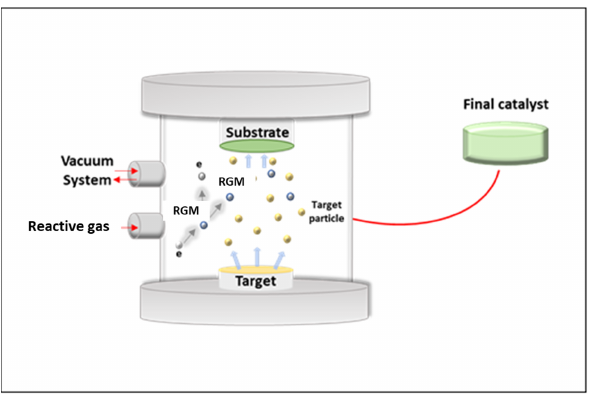
Figure 3. Schematic representation of the sputtering process. RGM: reactive gaseous molecule.